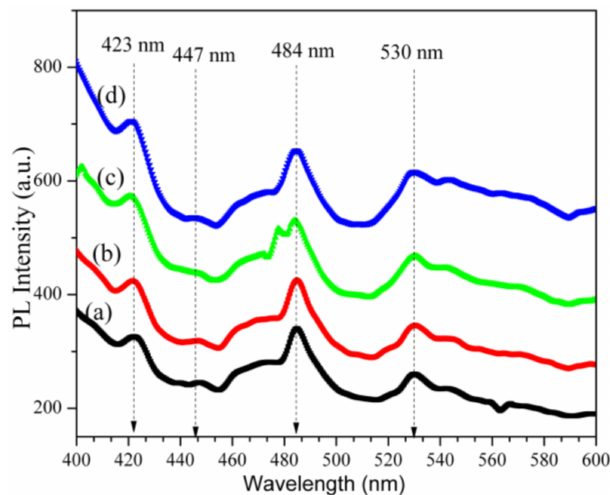
Figure 12. PL spectra of the willemite NPs calcined at 900 ◦ C with different calcination holding times: ( a ) 1 h ( b ) 2 h ( c ) 3 h and ( d ) 4